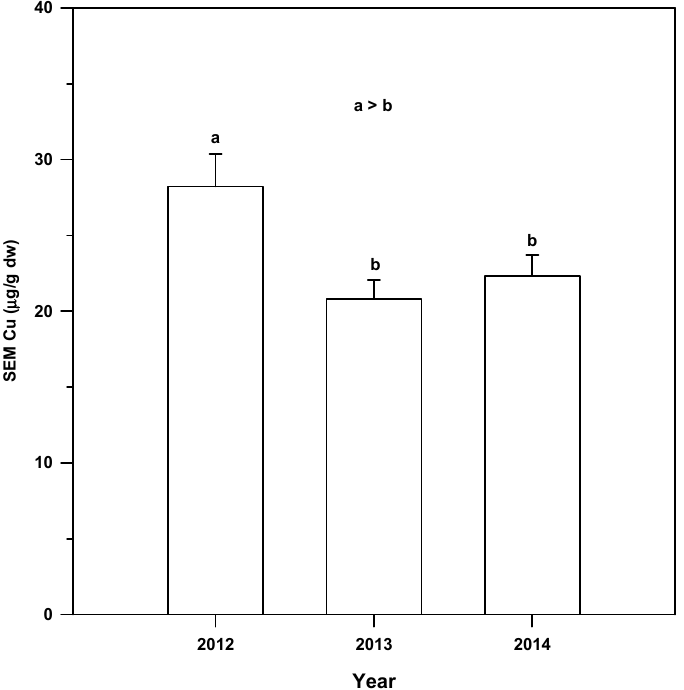
Figure 25. All Cache Slough SEM Cu sediment data by year (ANOVA, p = 0.004). a,b: The year 2012 is significantly different from the years 2013 and 2014 (Holm-Sidak Method, p ≤ 0.050).